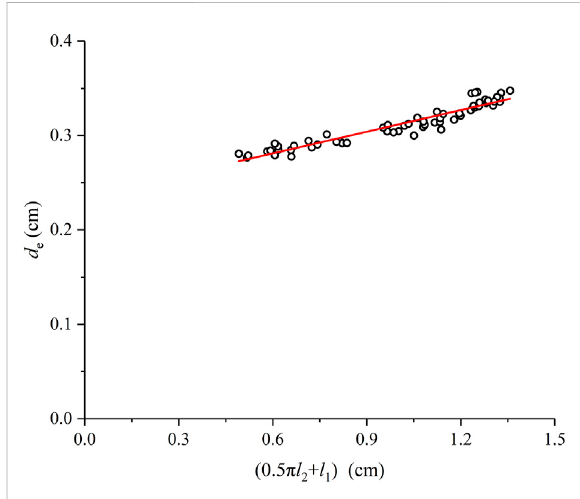
FIGURE 8 Thevariationrelationshipbetweenthetotallengthandthehe diameter of the volume-equivalent